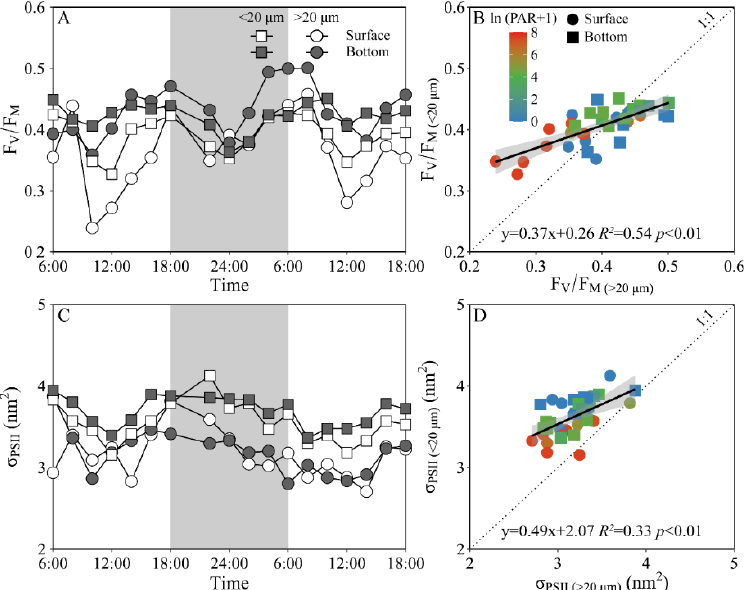
Figure 4. Daily changes in the maximum photochemical quantum yield ( A , F V /F M ) of Photosystem II (PSII) and absorption cross section for PSII photochemistry ( C , σ PSII , nm 2 ) of piconano- (<20 µm) and micro-cell assemblies (>20 µm) in surface and bottom layers of experimental site, as well as the comparisons of ( B ) F V /F M or ( D ) σ PS II between piconano- and micro-cell assemblies. Grey shadows in panels A and C indicate the nighttime. Solid lines in panels B and D show the linear regression with shadow indicating 95% confidence interval; and the color in symbol indicates the ln(PAR + 1) wherein the PAR is the cell-received irradiance in field condition.